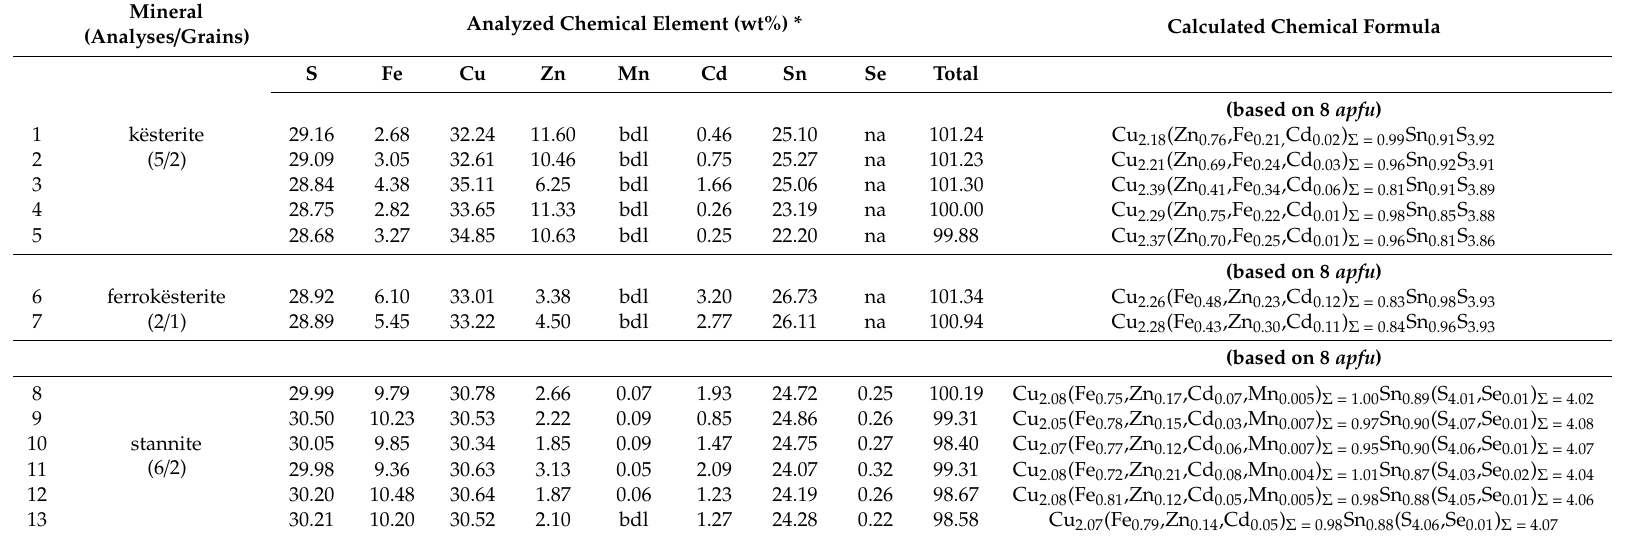
Table 4. Quantitative chemical data (wt%) for kësterite, ferrokësterite, and stannite from the Blidar Contact ore body. Mineral (Analyses /